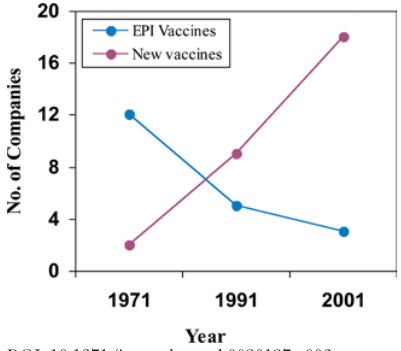
Figure 2. The Growth of the Private Sector in the Indian Vaccine Market The data were compiled from the annual reports of Health Information of India (1970–1971 to 2001–2002), the Ministry of Health and Family